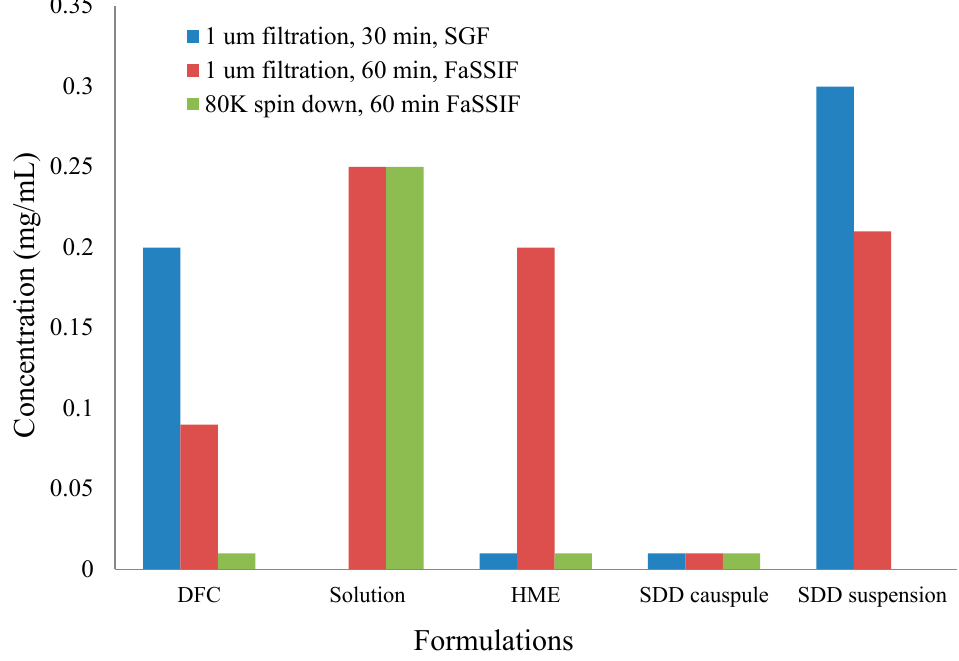
Figure 6. 1- µ m filtration and 80 K ultracentrifugation results of two-stage dissolution of different formulations. FaSSIF, fasted state simulated intestinal fluid.